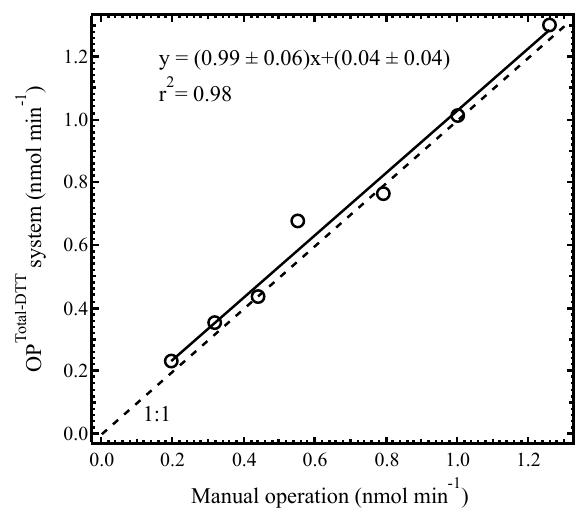
Figure 4. DTT consumption rate (blank-corrected) comparison of the automated system for measuring OP Total-DTT (shown in Fig. 2) to a manual analysis using PQN (9,10-phenanthraquinone). Slope ( ± 1 standard deviation) and intercept ( ± 1 standard deviation) are based on orthogonal